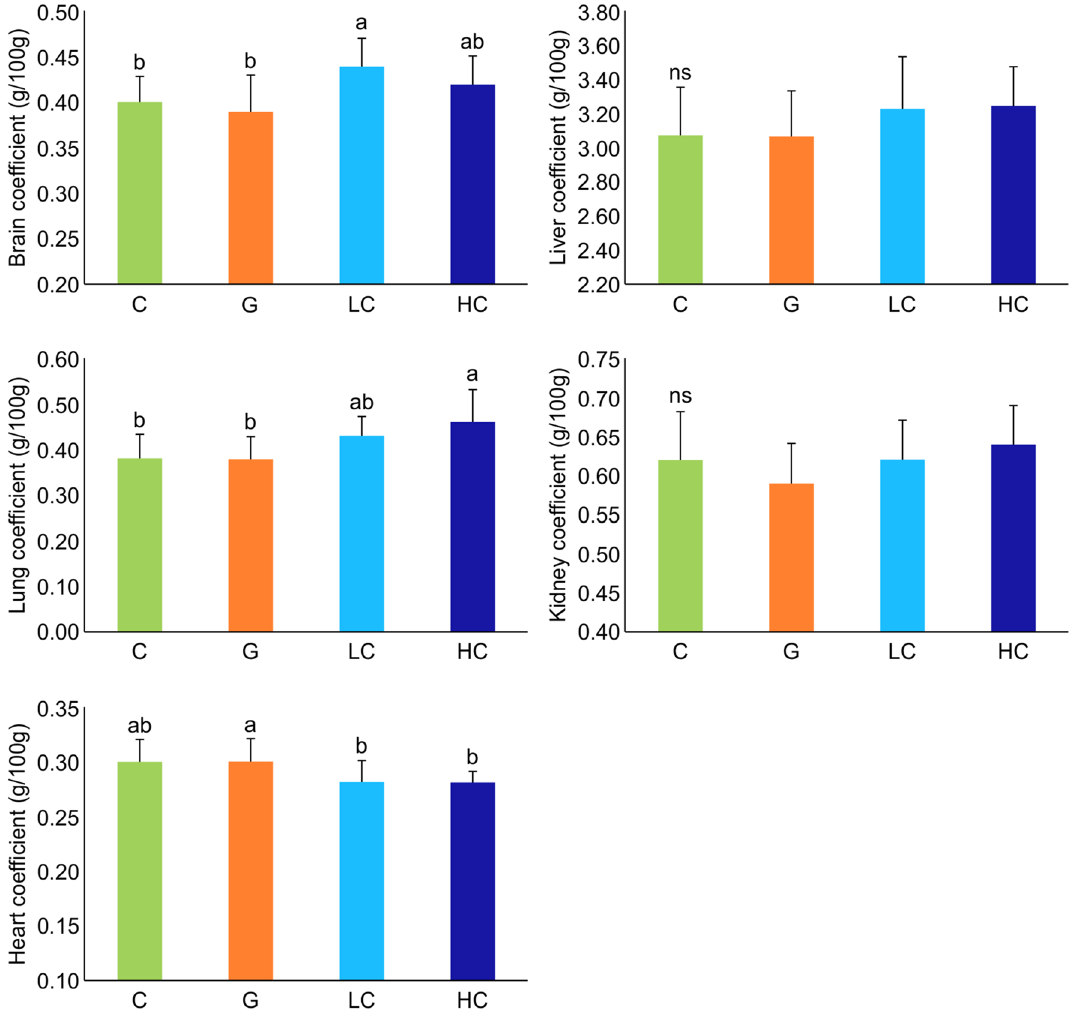
Figure 2. Organ coefficients of each group. Values represent mean ± SD, n = 8. ns: not significant; Means for a variable with different letters (a and b) within a column differ significantly ( p < 0.05). C, control; G, d-galactose- induced aging; LC, d-galactose injection with 10% cacao powder mixed diet; HC, d-galactose injection with 16% cacao powder mixed